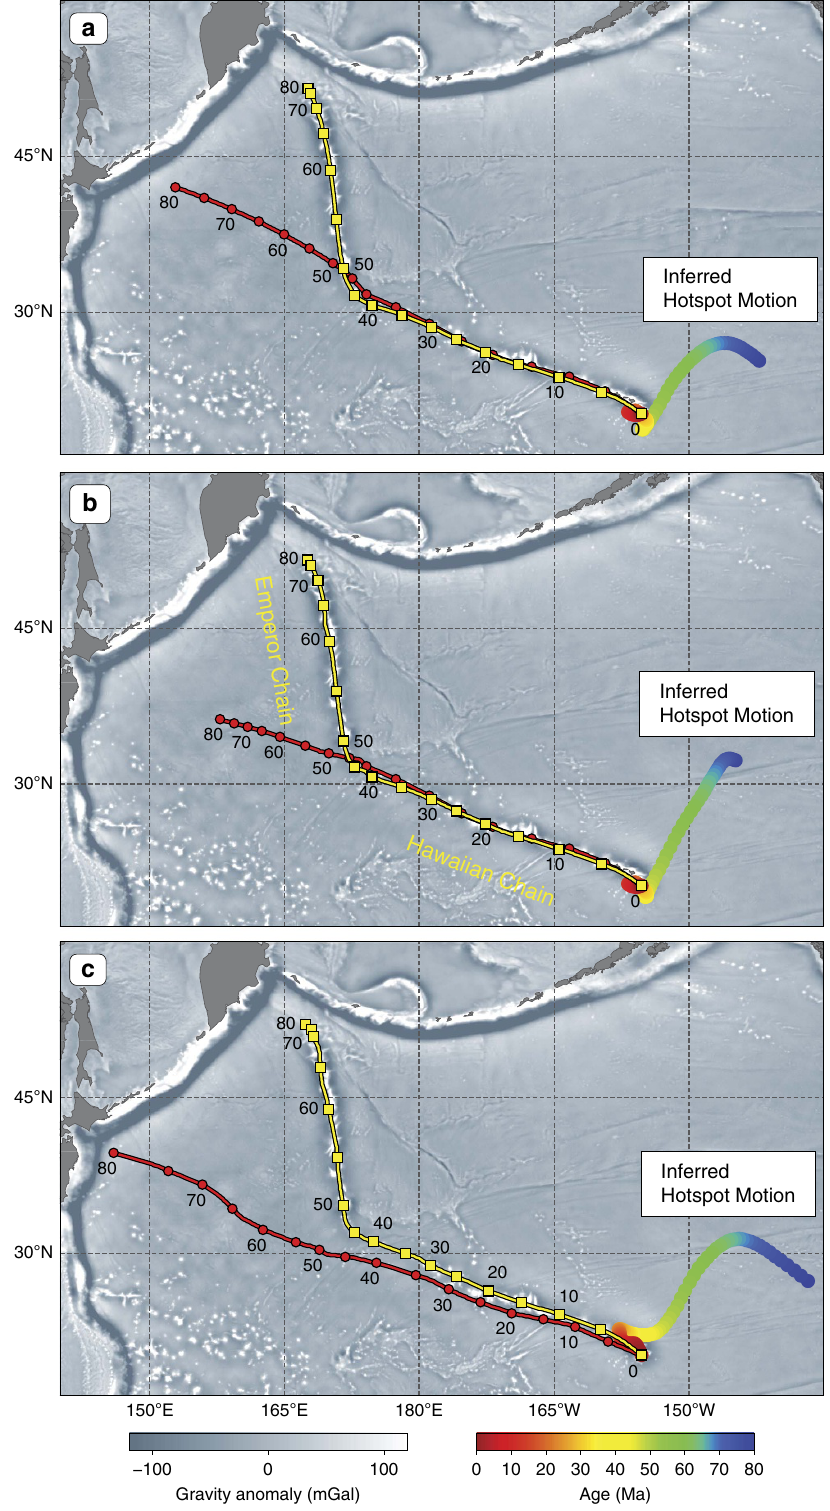
Figure 4 | Motion of the Hawaiian hotspot inferred from absolute kinematic models. The multi-coloured swaths represent inferred paths of hotspot drift, which, when combined with the Pacific absolute plate motion (APM), produce model hotspot tracks (yellow lines) that accurately track the geometry of and the age progression along the Hawaiian-Emperor Chain (see Methods for details). The red lines track the Pacific APM over an assumed fixed hotspot. Three APM models that do not feature a prominent change in the Pacific plate motion at the time of the HEB formation were considered. ( a ) Pacific APM model of Chandler et al. 27 (WK08-D). ( b ) The geodynamic APM model of Butterworth et al. 24 (42–72Myr ago), augmented by the rotations from Wessel and Kroenke 52 (WK08-A) for the younger ages, and extrapolated to 83Ma as in Wessel & Mu¨ller 53 . ( c ) APM model based on the Indo-Atlantic moving hotspot reference frame of O’Neill et al. 39 and using the relative plate motions of Seton et al. 26 updated by Shephard et al.